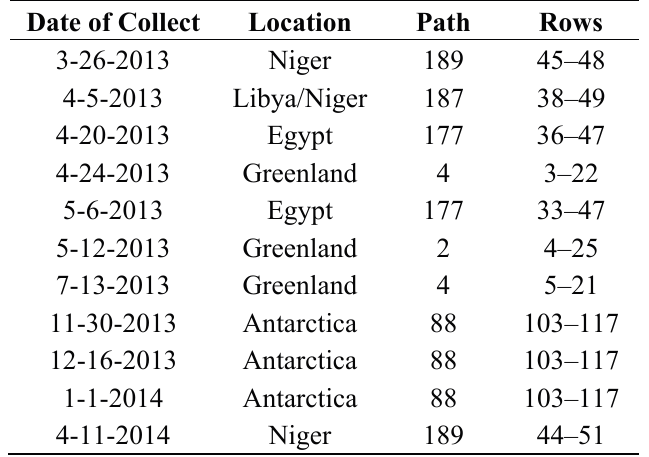
Table 2. List of side-slither collects analyzed with WRS-2 path/row coverage. Date of